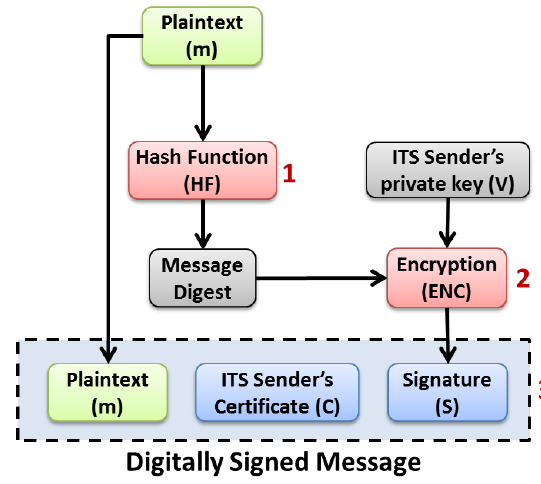
Figure 5. ECDSA based message signature